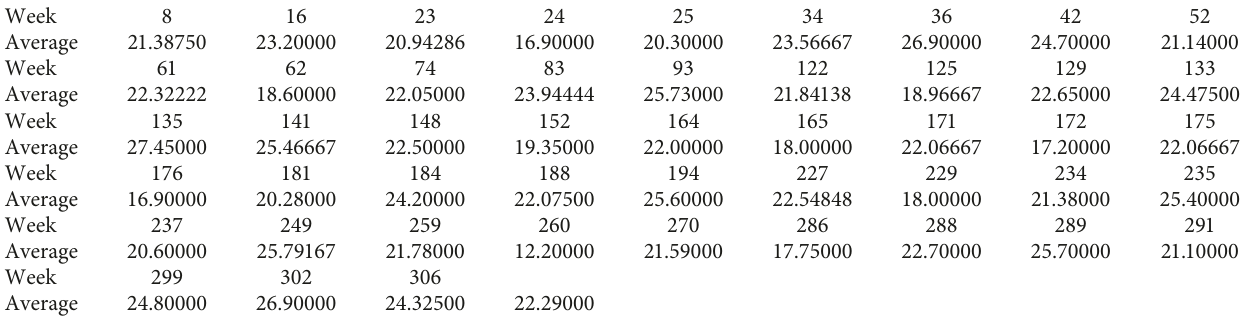
Table 6: Location of change points in the mean of maximum temperature, determined with the PELT method.